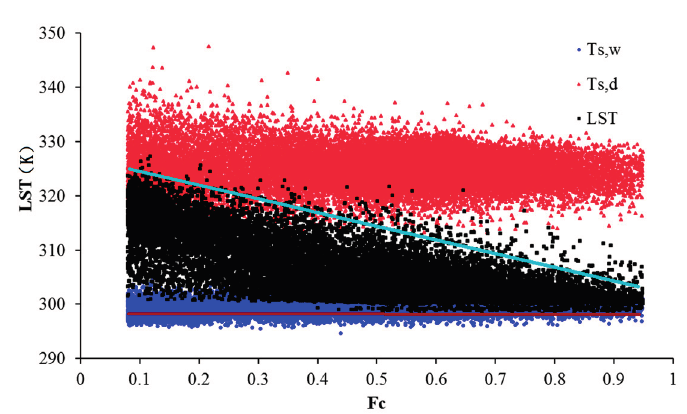
Figure 10. Comparison between the position of theoretical dry/wet boundaries (pixels) from SEBI and the dry/wet boundaries derived from LST-Fc diagram using the high resolution WiDAS image. The labels are identical to those in Figure